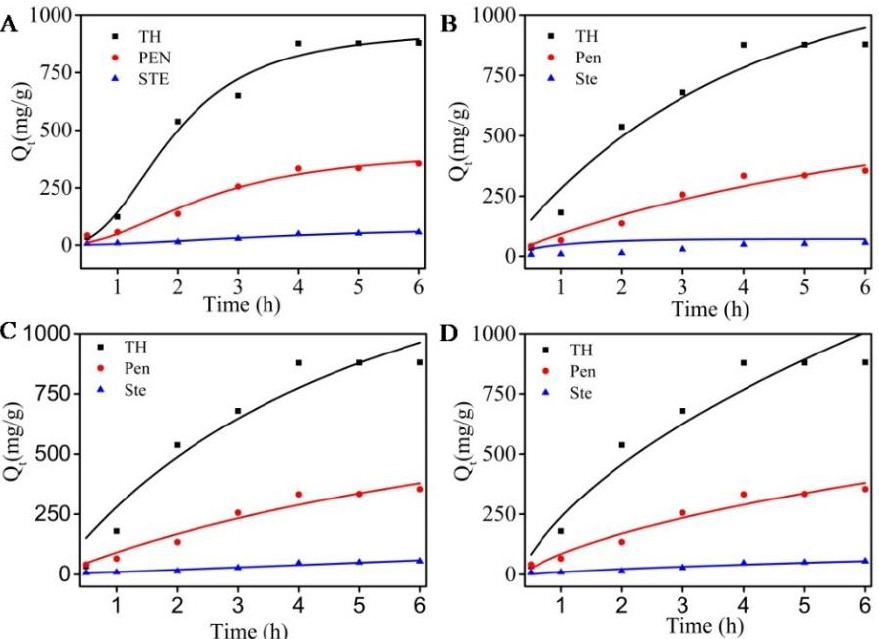
Molecules 2022 , 27 , 6735 7 of 12